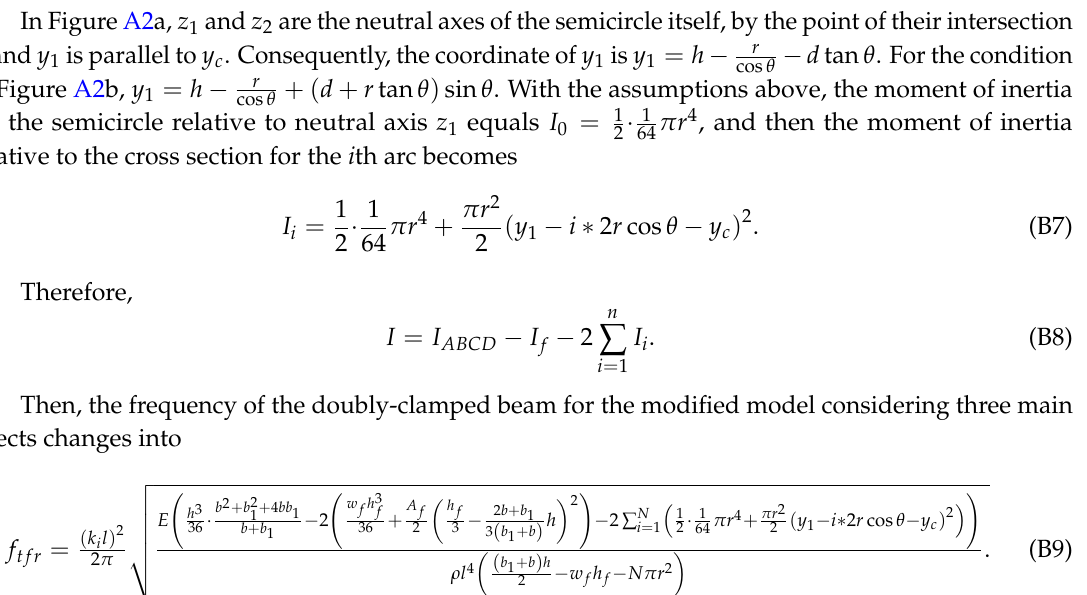
Figure B2. Coordinate sketch-map for the first arc. ( a ) the positive trapezoid (the upper length lower than the lower length) while the trapezoid angle θ > 0; ( b ) the negative one and θ < 0